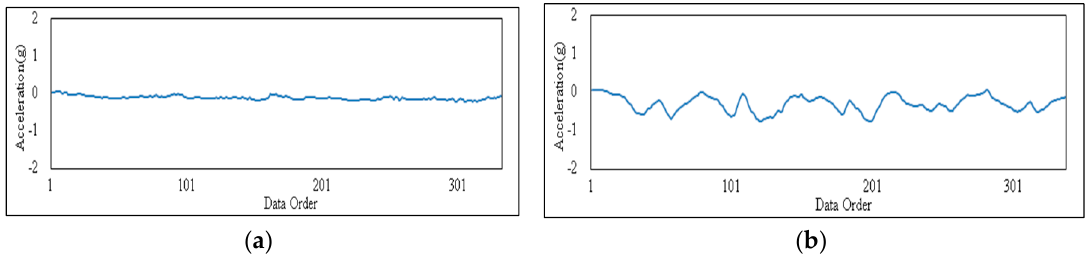
Figure 6. Flexion x-axis standard deviation comparison (a) stable x-axis acceleration data, (b) less- Figure 6. Flexion x -axis standard deviation comparison ( a ) stable x -axis acceleration data, ( b ) less-stable stable x-axis acceleration data. x -axis acceleration